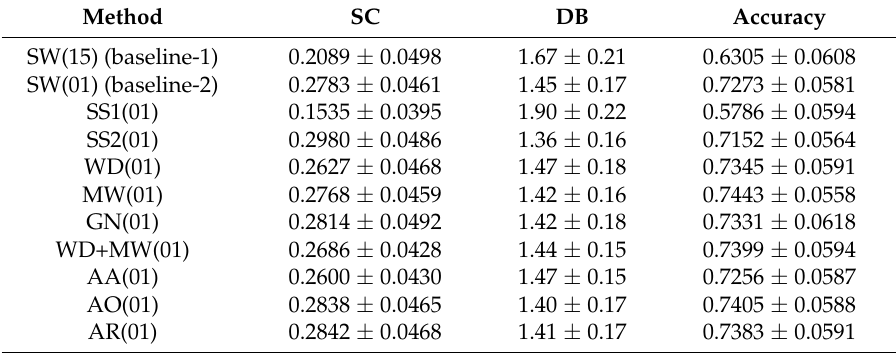
Table A8. Average and standard deviation across subjects of the cluster metrics Silhouette Coefficient (SC), Davies–Bouldin (DB) and classification accuracy (row of R = 9 in Table A6) for the Ninapro-DB1